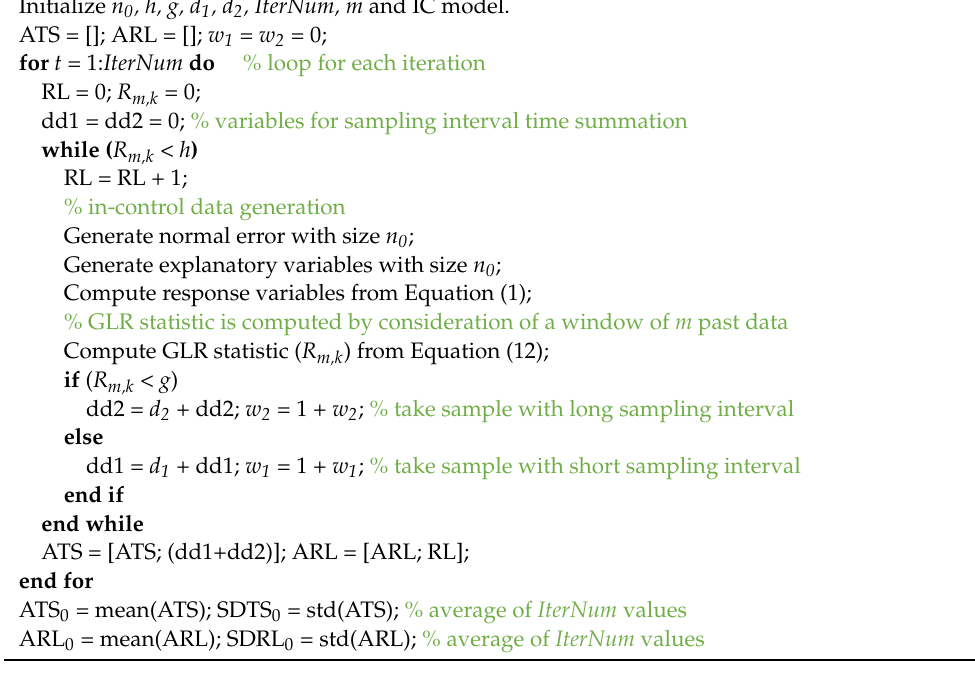
Pseudocode 2. The procedure of ATS 0 and SDTS 0 computations in